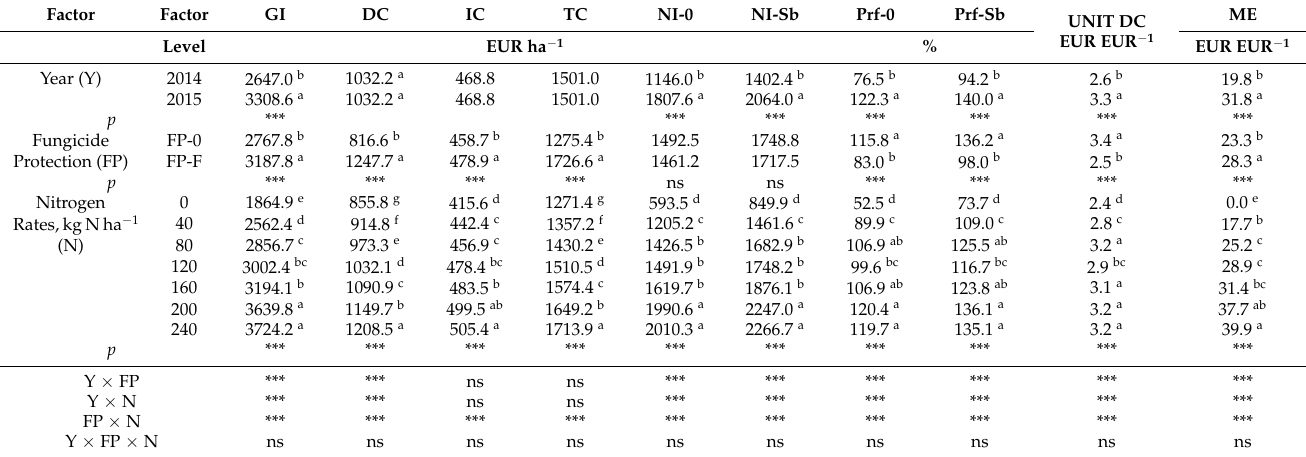
Figure 7. Effect of winter wheat protection with fungicides and rates of fertiliser nitrogen on gross income. Similar letters in the column means a lack of significant differences using Tukey’s test; the vertical bar in the column refers to the standard error of the mean. Table 4. Economic indicators—simulation of 2014 and 2015 for costs from